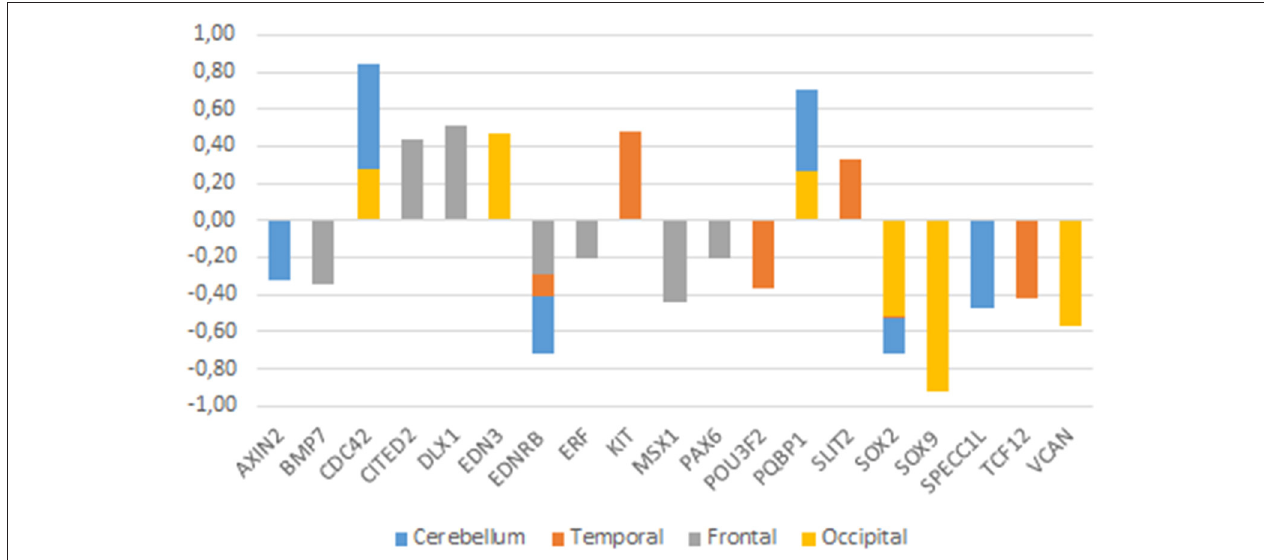
FIGURE 3 | Expression profiles of candidate genes in the ASD brain. Data were gathered from the following microarray expression datasets available on the Gene Expression Omnibus database (GEO datasets, http://www.ncbi.nlm.nih.gov/gds): GSE28521 (Voineagu et al., 2011) for the temporal and frontal cortices, GSE38322 ( Ginsberg et al., 2012) for the cerebellum and the occipital cortex. Data are shown as log transformation of fold changes (logFC) between patients and corresponding controls. Only genes showing statistically significant ( p < 0.05) differential expression were considered. Additional details may be found in the Supplemental information